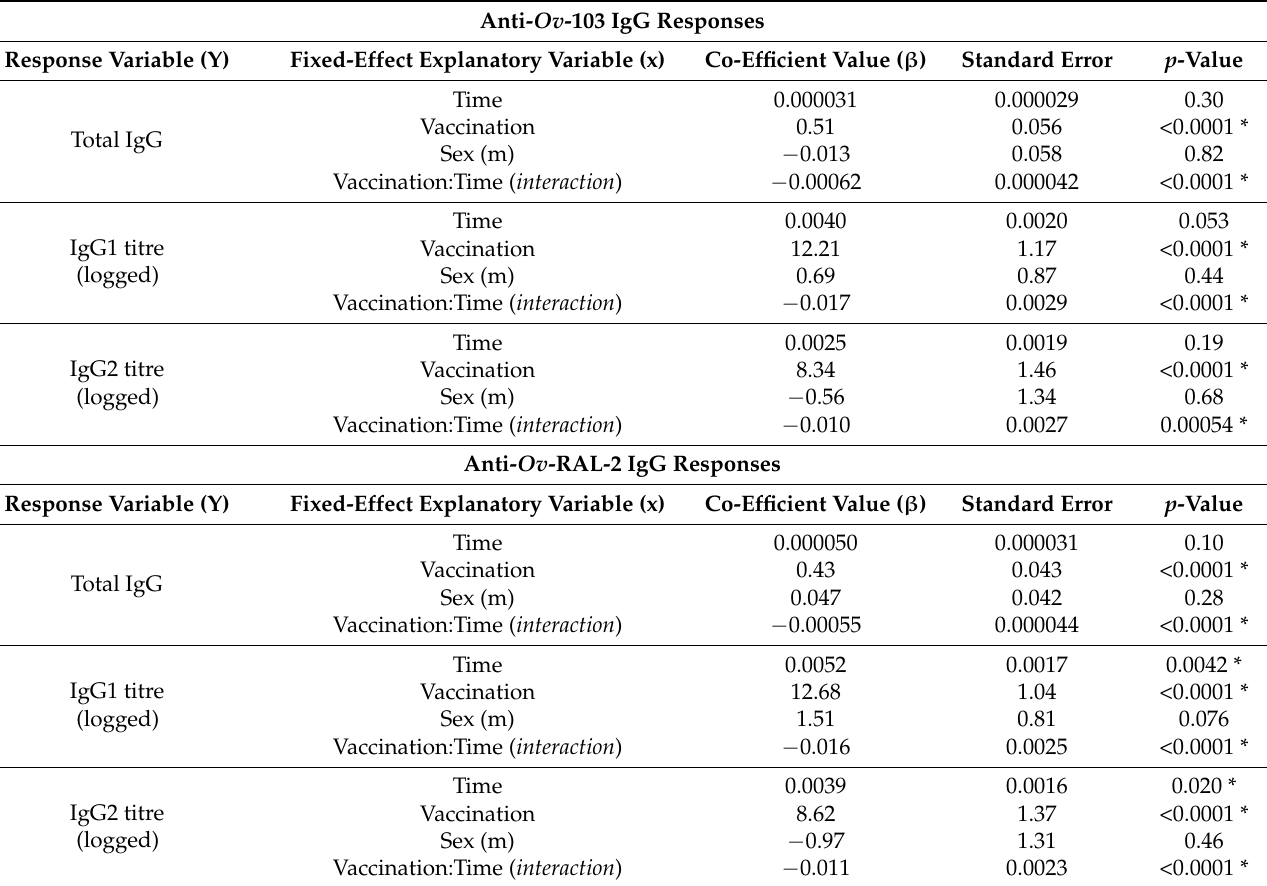
Table 5. Multivariable linear mixed effects regression analysis results (2 d. p ./2 s.f.) for antigen-specific antibody responses in vaccine efficacy trial calves over exposure period